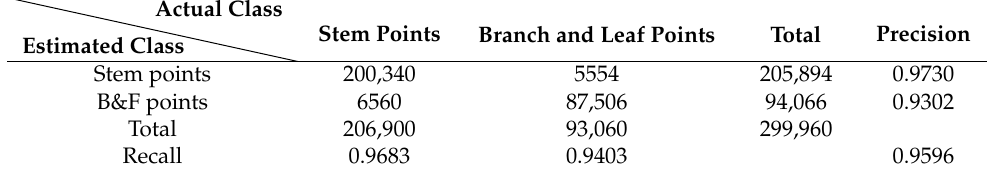
Figure 9. Classification results of the test sets. ( a ) Test set A. ( b ) Test set B. Table 4. Mixing matrix and precision value of test set A.